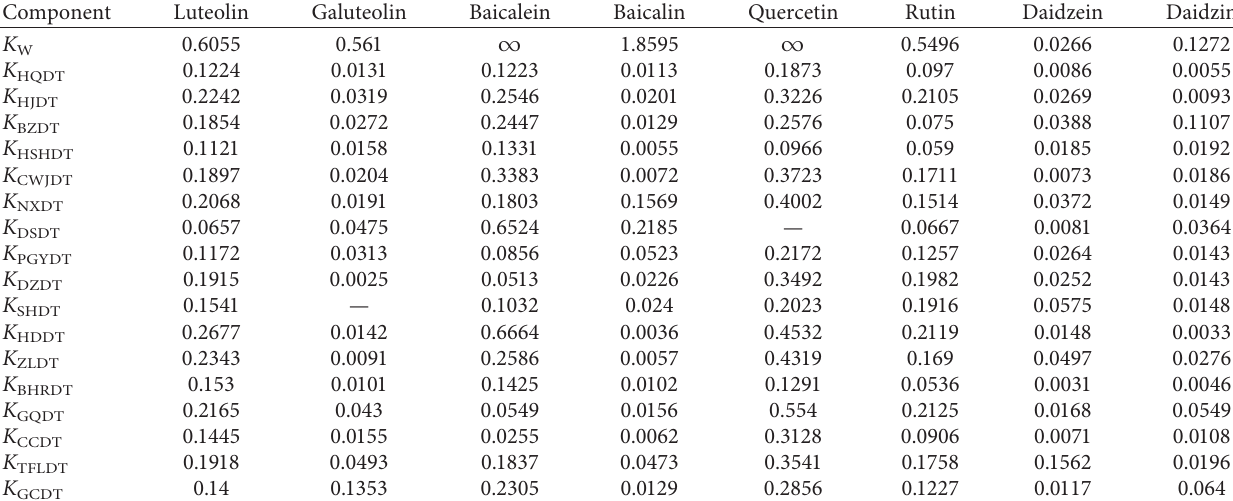
Table 3: Half-life t